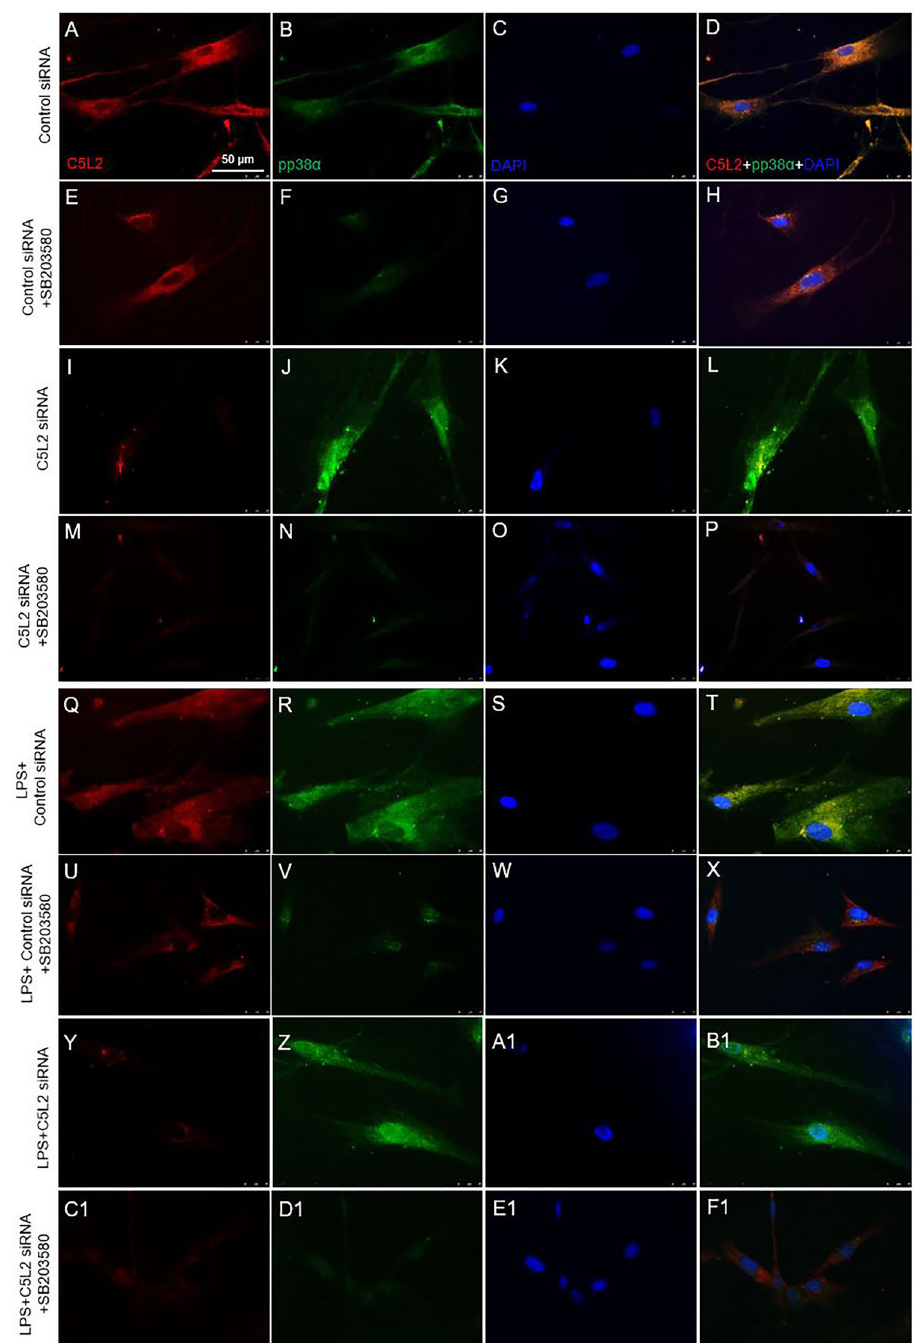
Figure 4. Effects of LPS on C5L2 mediated p38α phosphorylation in DPSCs. ( A - F1 ) Cells were cultured and treated with control siRNA ( A - D ), Control siRNA + SB203580 (E–H), C5L2 siRNA (I-L), or C5L2 siRNA + SB203580 ( M - P ), and/or stimulated with LPS ( Q - F1 ). Immunofluorescence double staining was used to analyze C5L2 and pp38α with or without LPS stimulation. C5L2 silencing enhanced phosphorylation of p38α in DPSCs with or without LPS ( I - L ; Y - B1 ) compared with cells treated with control siRNA alone or with LPS ( A - D ; Q - T ). Interestingly, SB203580 treatment with C5L2 siRNA reversed the effects and reduced the phosphorylation of p38α with or without LPS stimulation (M-P; C1-F1). ( G1 ) The bar graph shows a significant increase in p38α phosphorylation while SB203580 treatment remarkably reduced it. LPS stimulation enhanced the p38α phosphorylation and again SB203580 treatment reversed its effects (* p < 0.05, ** p < 0.01, and *** p < 0.001 vs control; # p < 0.05, ## p < 0.01, and ### p < 0.001 vs respective line-indicated group). ( H1 ) The in-cell western assay was performed to access p38 and p38α phosphorylation with or without LPS stimulation. It was observed that LPS stimulation significantly increase phosphorylation of p38 and p38α which further testify the above-mentioned